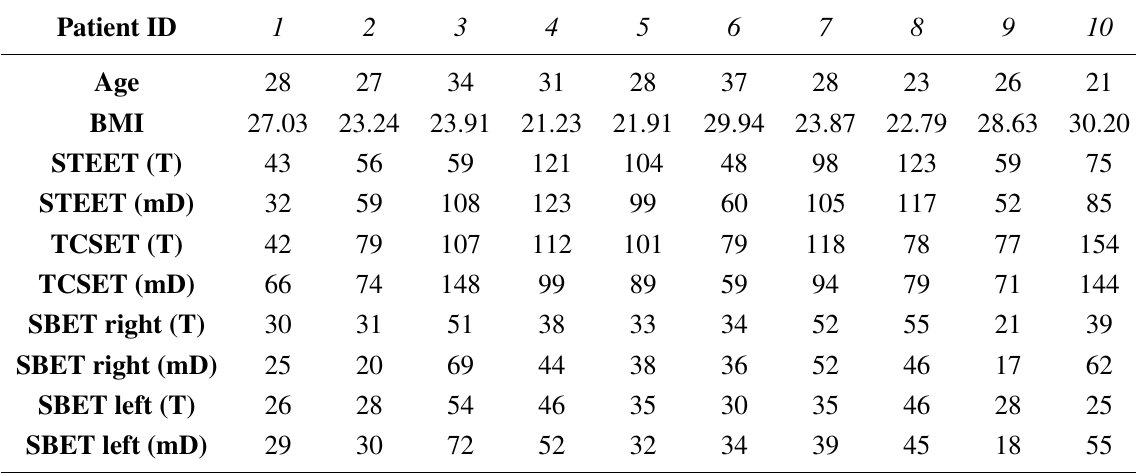
Table 2. Case study results. BMI values are expressed in kg/m 2 and the test duration in